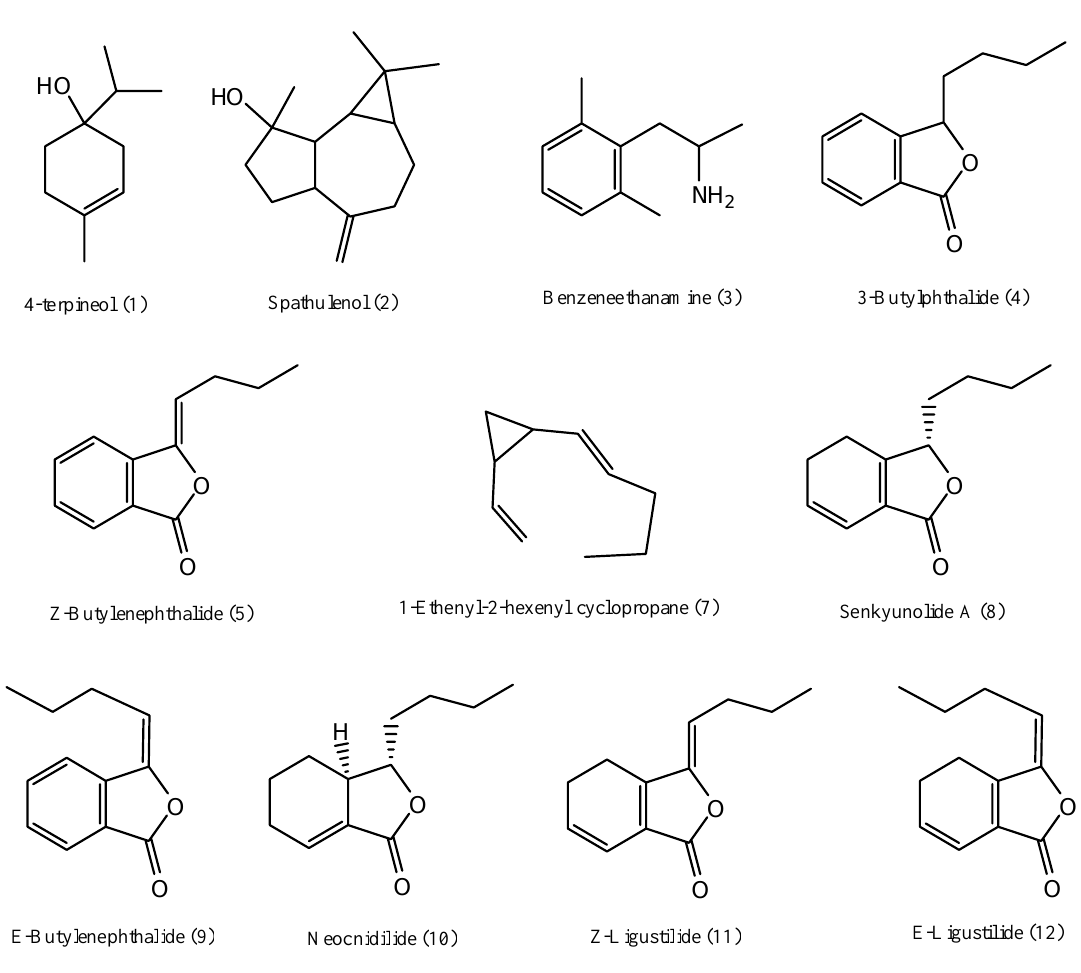
Figure 2. The structures of twelve compounds identified in essential oils from SWT, FSS, RA and